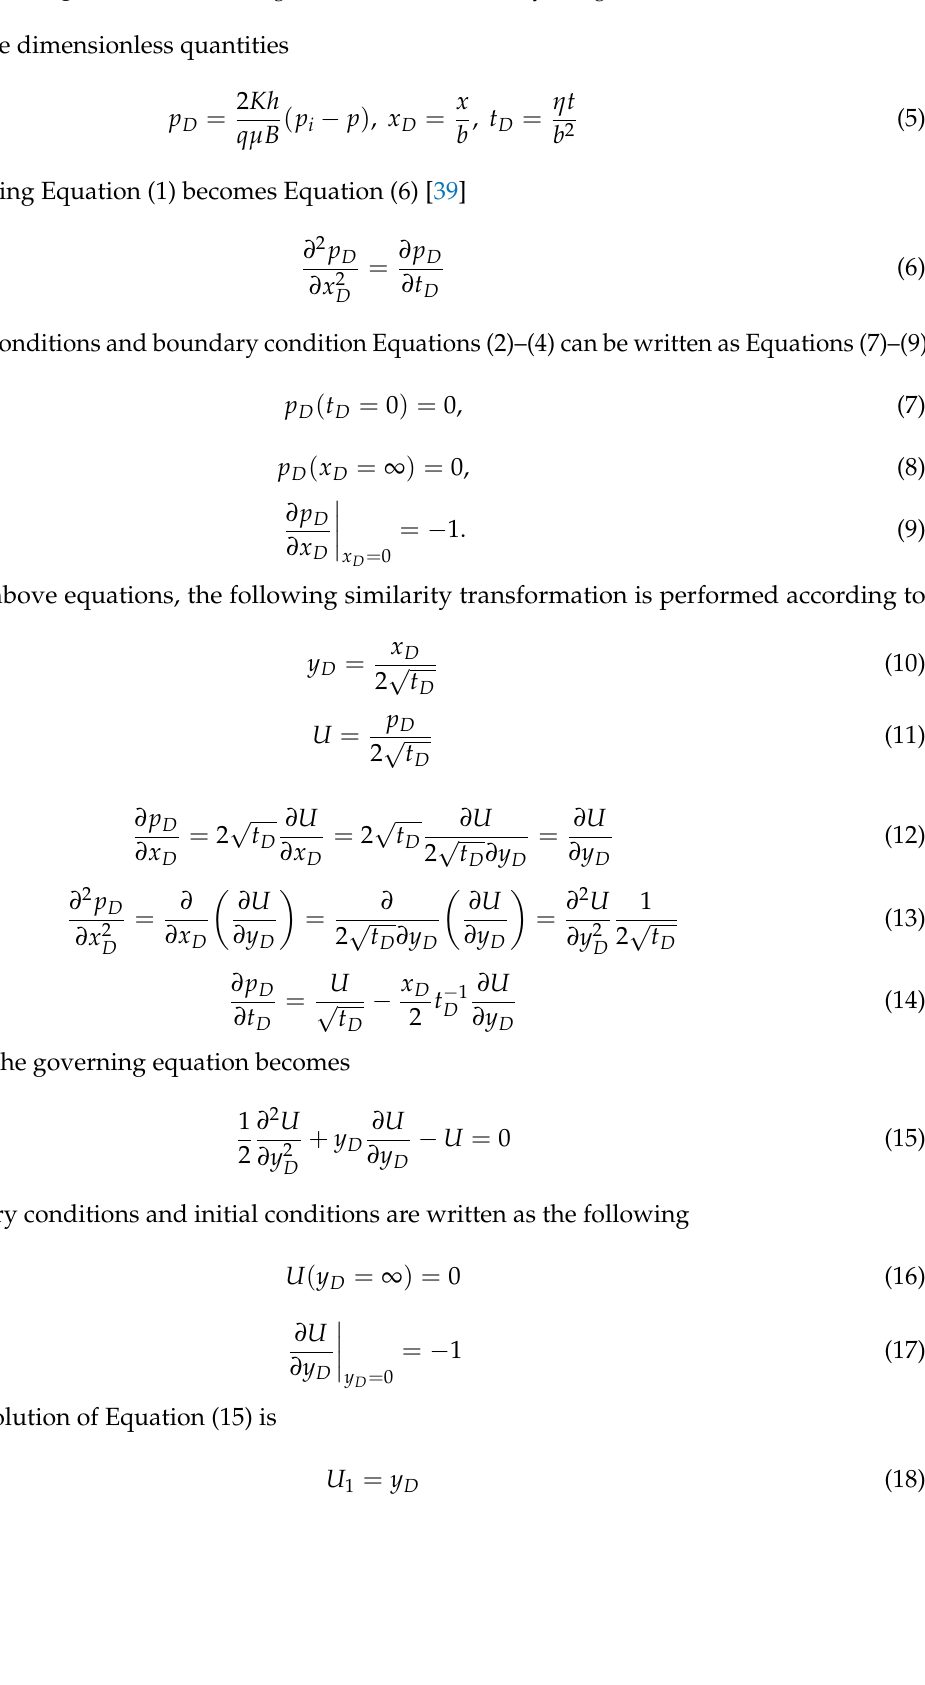
Figure 2. Schematic diagram of wells connected by a large